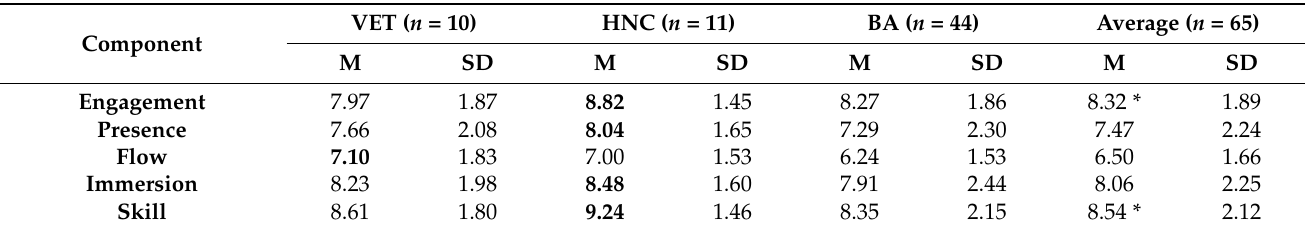
Table 2. Mean (M) and Standard Deviation (SD) of satisfaction and usability survey of the three groups and for all the students treated as one single